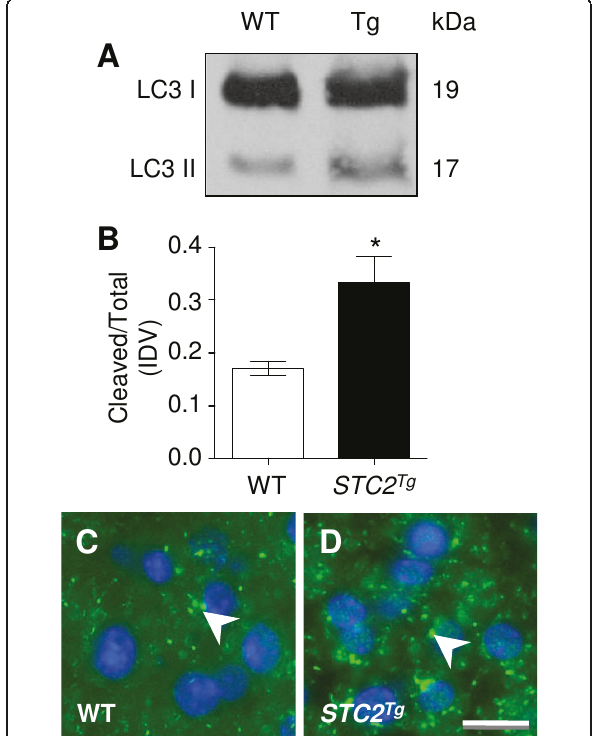
PERK signalling pathway. Xbp1 mRNA is targeted by the endonuclease activity of IRE1 leading to production of an active, spliced (s) form of XBP1 [26]. Western blot analysis revealed a consistent decreased in sXBP1 accu- mulation in STC2 Tg mice indicating that elevated STC2 levels may also affect the other UPR pathways.